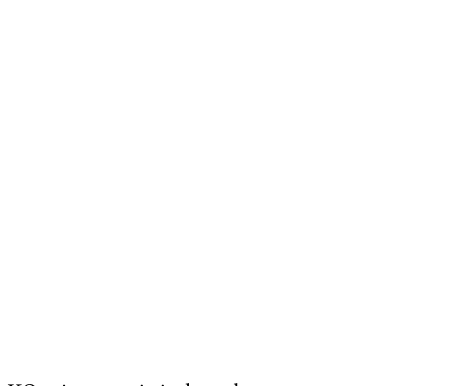
Table 8. Effects of CL-316,243 3 on VO 2 in WT and UCP-1 KO mice – statistical